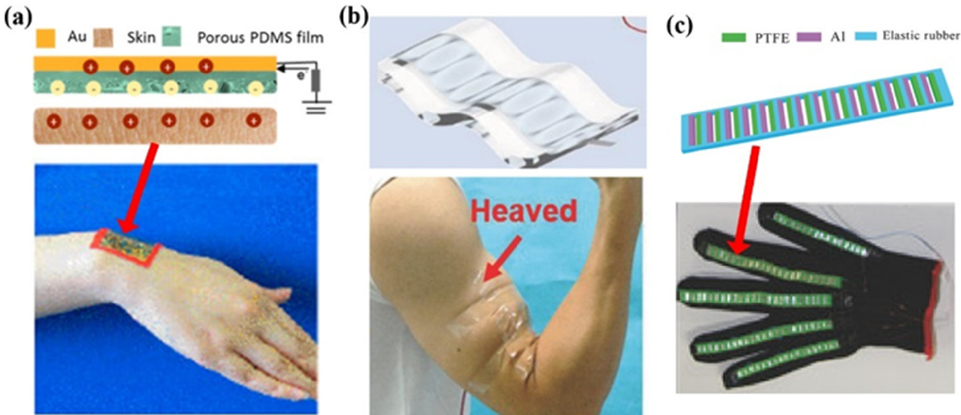
Figure 3. Structures of single-electrode mode TENGs: ( a ) A flexible film-structured TENG attached to skin (Reproduced with permission [22]. Copyright 2018 American Chemical Society); ( b ) A flexible and stretchable TENG with wrinkled structure (Reproduced with permission [46]. Copyright